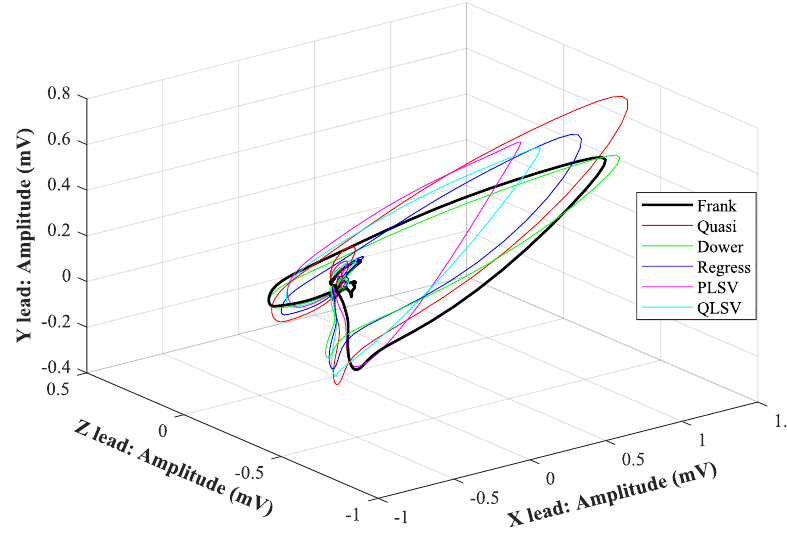
Figure 10. Comparison of transformation methods in 3-D, random patient